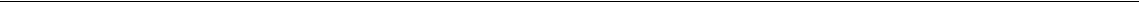
Fig. 3g), con fi rming that Insc ASYM - Δα B assemble in a lower stoichiometry complex than